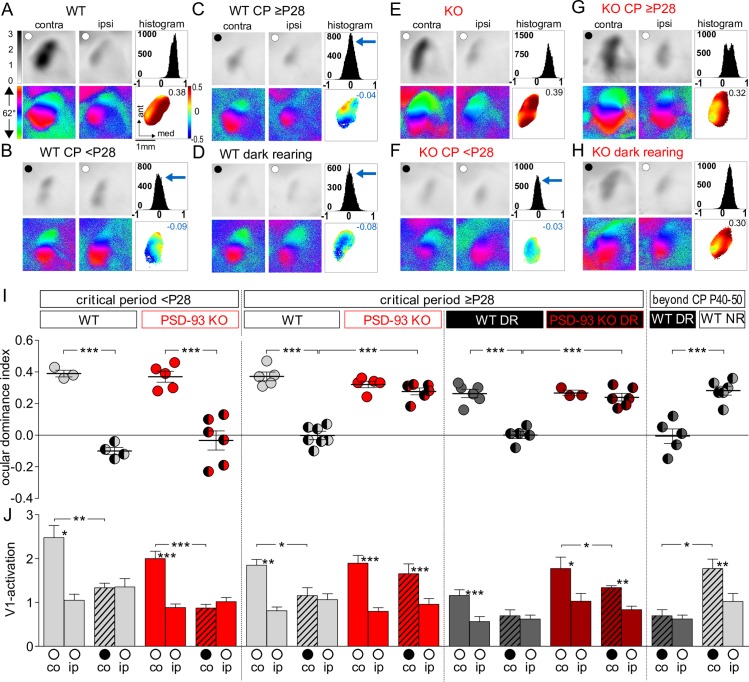
Precocious closure of the critical period for juvenile ODP in PSD-93 KO mice.(A-H) Optically imaged activity and retinotopic maps in V1 of WT (A–D) and PSD-93 KO mice (E-H) during mid CP (<P28 = P24–P27), during late CP (≥P28 = P28–P35), and beyond the CP (P40–P50) before (A and E) and after 4 d of MD (WT: B-D and KO: F-H). V1 images of DR WT and PSD-93 KO mice after 4 d MD are illustrated in D and H. Grayscale coded response magnitude maps (top rows, expressed as fractional change in reflectance ×10−4), color-coded maps of retinotopy (bottom rows), histogram of OD scores (top right of panels), and color-coded OD maps (bottom right, including average ODI) are illustrated. In control mice of both genotypes (A and E), activity patches evoked by stimulation of the contralateral (contra) eye were always darker than those evoked by the ipsilateral eye (ipsi) stimulation, the average ODI was positive, and warm colors prevailed in the two-dimensional OD maps, indicating contralateral dominance. After 4 d of MD (MD eye illustrated as black spot), there was an OD shift towards the open eye in WT mice during mid (B) and late CP (C), and beyond the CP after dark rearing (D), whereas PSD-93 KO mice only showed an OD shift during mid CP (F), which was already absent in late CP (G) and not rescued after dark rearing (H). After MD in WT mice, the ODI histogram shifted leftwards (blue arrows), the ODI decreased, and colder colors prevailed in the OD maps (negative ODI values). In contrast, in PSD-93 KO mice, OD plasticity was absent beyond P28 (compare F and G), and the deprived, contra eye continued to dominate V1 (G). (I, J) Summary graph of ODI (I) and V1 activation (J). ○, open eyes; ●, deprived eyes. ODIs (I) and V1 activation (J) before (oo) and after (●o) 4 d MD in PSD-93 KO (red) and WT mice (light gray). Values of DR mice are illustrated in darker colors. Symbols in I represent ODI values of individuals; means are marked by horizontal lines. (J) V1 activation elicited by stimulation of the contra (co) or ipsi (ip) eye. Note that juvenile OD plasticity persisted in WT mice after the CP (beyond CP) after dark rearing (WT DR), but not in NR WT mice, whereas it was absent in both late CP (≥P28) and DR (≥P28) PSD-93 KO mice. Furthermore, all OD shifts after 4 d of MD were primarily mediated by reductions of deprived eye responses in V1 (J). *p < 0.05, **p < 0.01, ***p < 0.001. Underlying data for this figure can be found in S1 Data. ant, anterior; co, contralateral; contra, contralateral; CP, critical period; DR, dark-reared; ip, ipsilateral; ipsi, ipsilateral; KO, knock-out; MD, monocular deprivation; med, medial; NR, normal-reared; ODI, ocular dominance index; ODP, ocular dominance plasticity; P, postnatal day; PSD, postsynaptic density; V1, primary visual cortex; WT, wild-type.